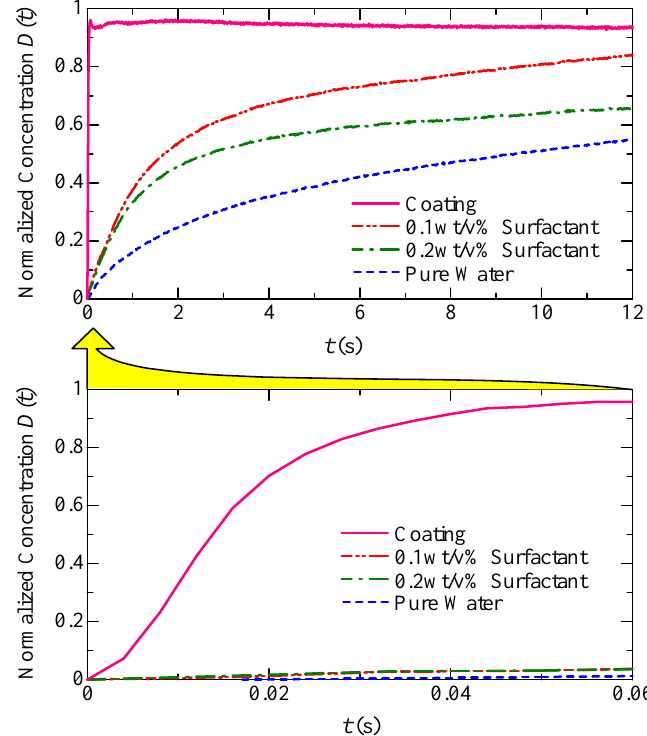
Figure 7. Normalized concentration D ( t ) (Equation (1)) with respect to time, where the horizontal and vertical axes represent time and D ( t ) ,